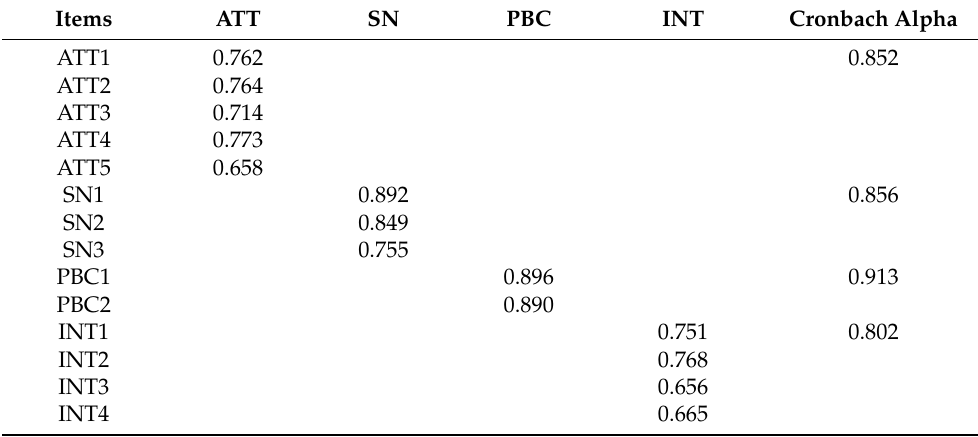
Table 3. Results of the factor analysis and reliability for all the variables.